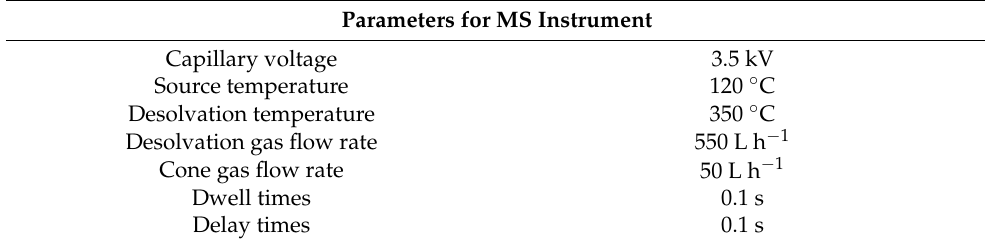
Table 3. Applied mass spectrometer parameters and source